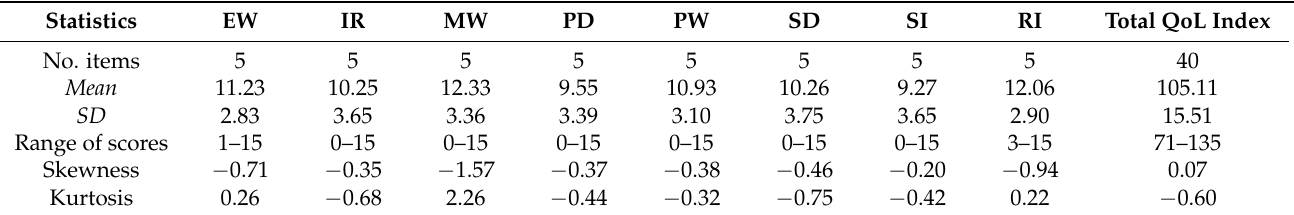
Table 2. Description statistics of quality of life (QoL) scores one-year follow-up.